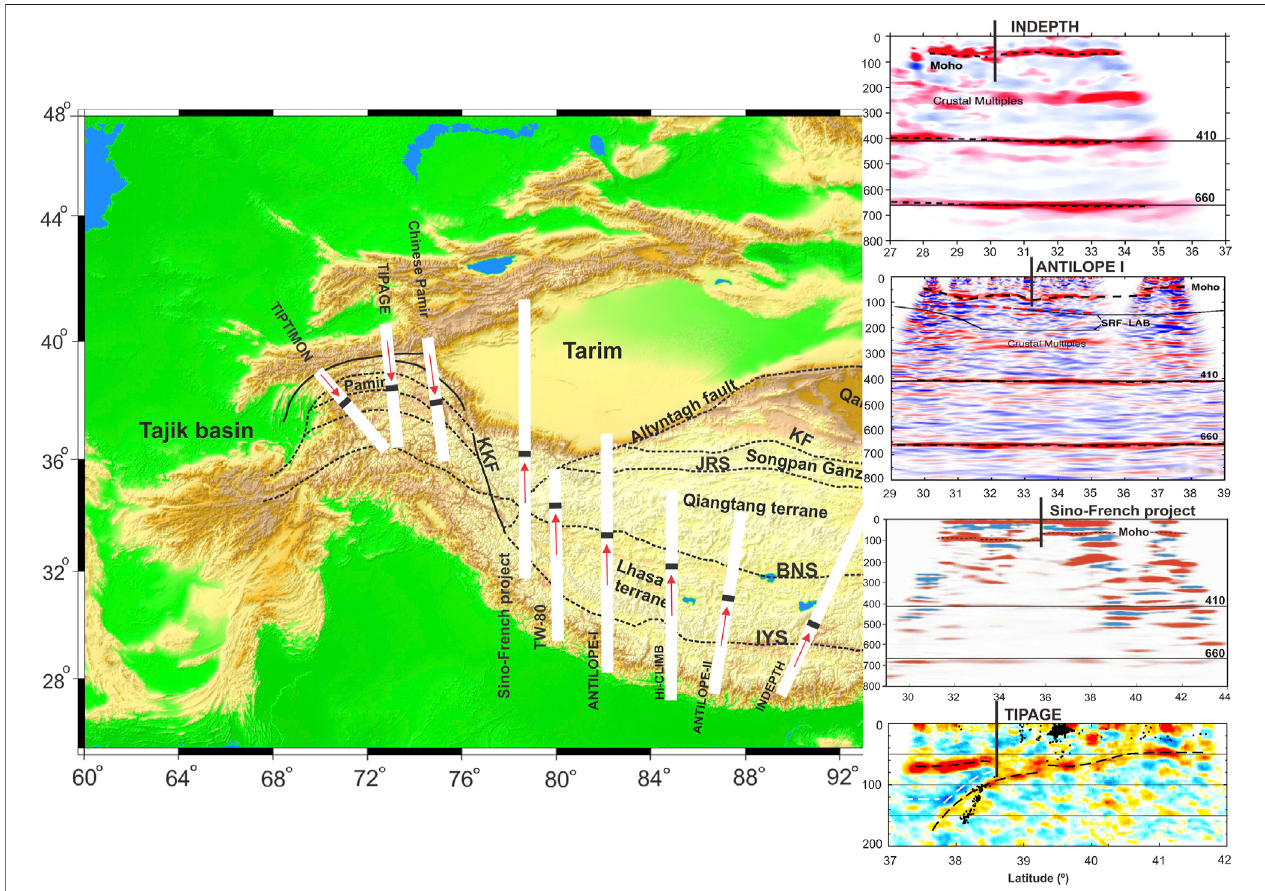
FIGURE 5 | N – S Moho discontinuity derived from receiver functions images beneath the Pamir – Tibetan plateau along INDEPTH (Kind et al., 2002), Hi-CLIMB (Náb ě leketal.,2009),ANTILOPE I,II(Zhaoet al.,2010),TW-80(Zhangetal.,2014),Sino-Frenchproject(Wittlingeretal.,2004),ChinesePamir(Xuetal.,2021),TIPAGE (Schneider et al., 2013), and TIPTIMON (Schneider et al., 2019) projects. The vertical black lines in the cross-sections and the black lines along the pro fi les indicate the northern boundary of the underthrusting Indian plate, where the red arrows show subducting/underthrusting direction of the plates.